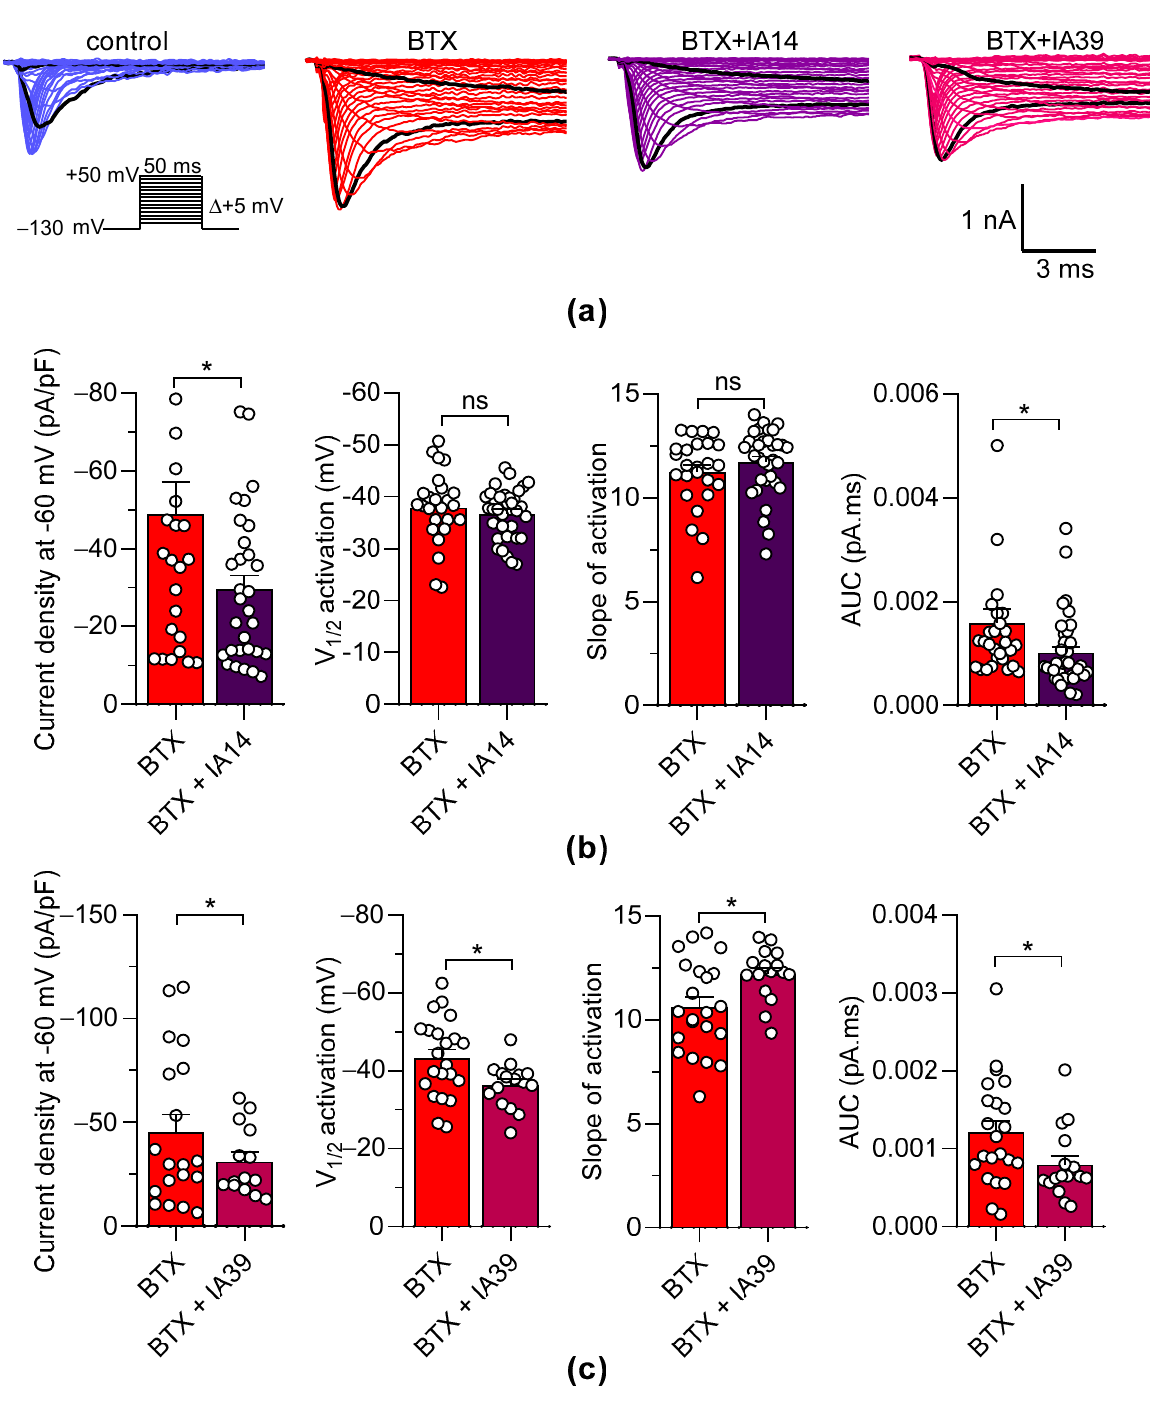
Figure 9. Effects of oxostephanine and liriodenine on Na + currents elicited by hNa V 1.3 in the presence of batrachotoxin. Oxostephanine (IA14) and liriodenine (IA39) were assayed at 10 µ M each on Na + currents elicited by the hNa V 1.3 channel in the presence of batrachotoxin (BTX, 1 µ M). ( a ) Representative examples of Na + currents elicited by 50 ms depolarization steps (protocol inset). To illustrate the strong effect of 1 µ M BTX, traces at − 60 mV and 20 mV are shown in black. ( b , c ) The scatter plots with bars illustrate: the current densities at − 60 mV, the V 1/2 of activation, the slope of activation curves, and the area under the curve (AUC in pA.ms) in the absence or in the presence of IA14 ( b ) and IA39 ( c ). Data are shown as mean ± SEM. Parametric or non-parametric statistical analyses were performed to determine the significance between groups. *, p < 0.05; ns: not significant.